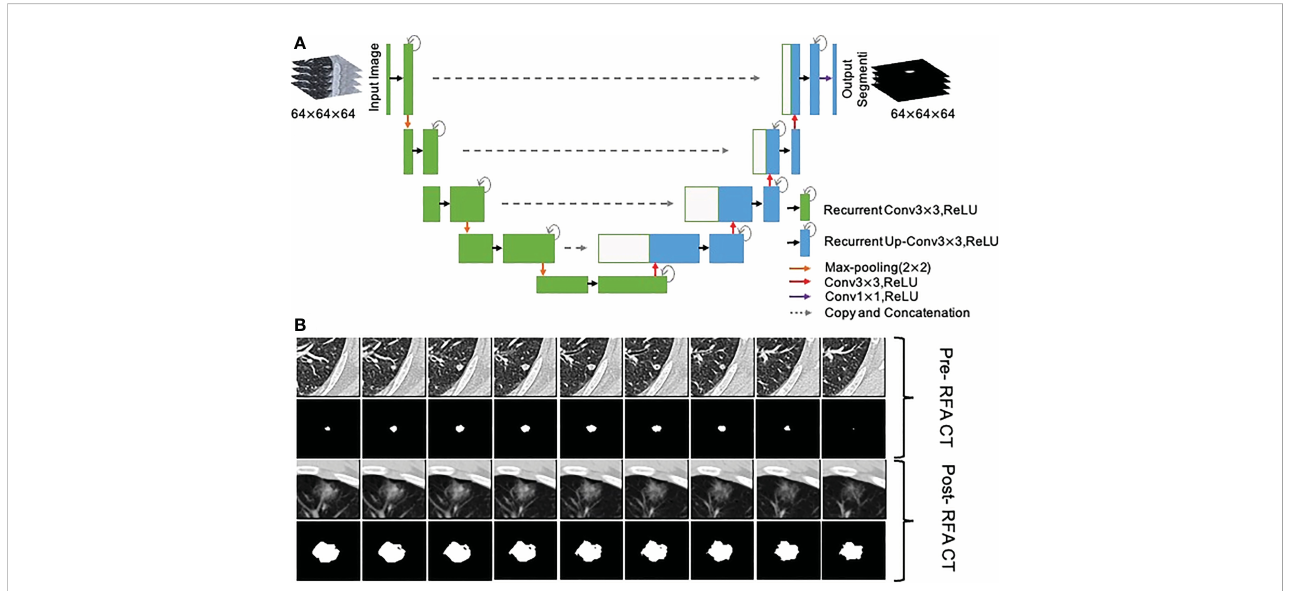
FIGURE 3 Segmentation of metastasis and ablation area. (A) Flow chart of the 3D U-Net model; (B) CT images and segmentation images of colorectal cancer lung metastasis and ablation area immediate after